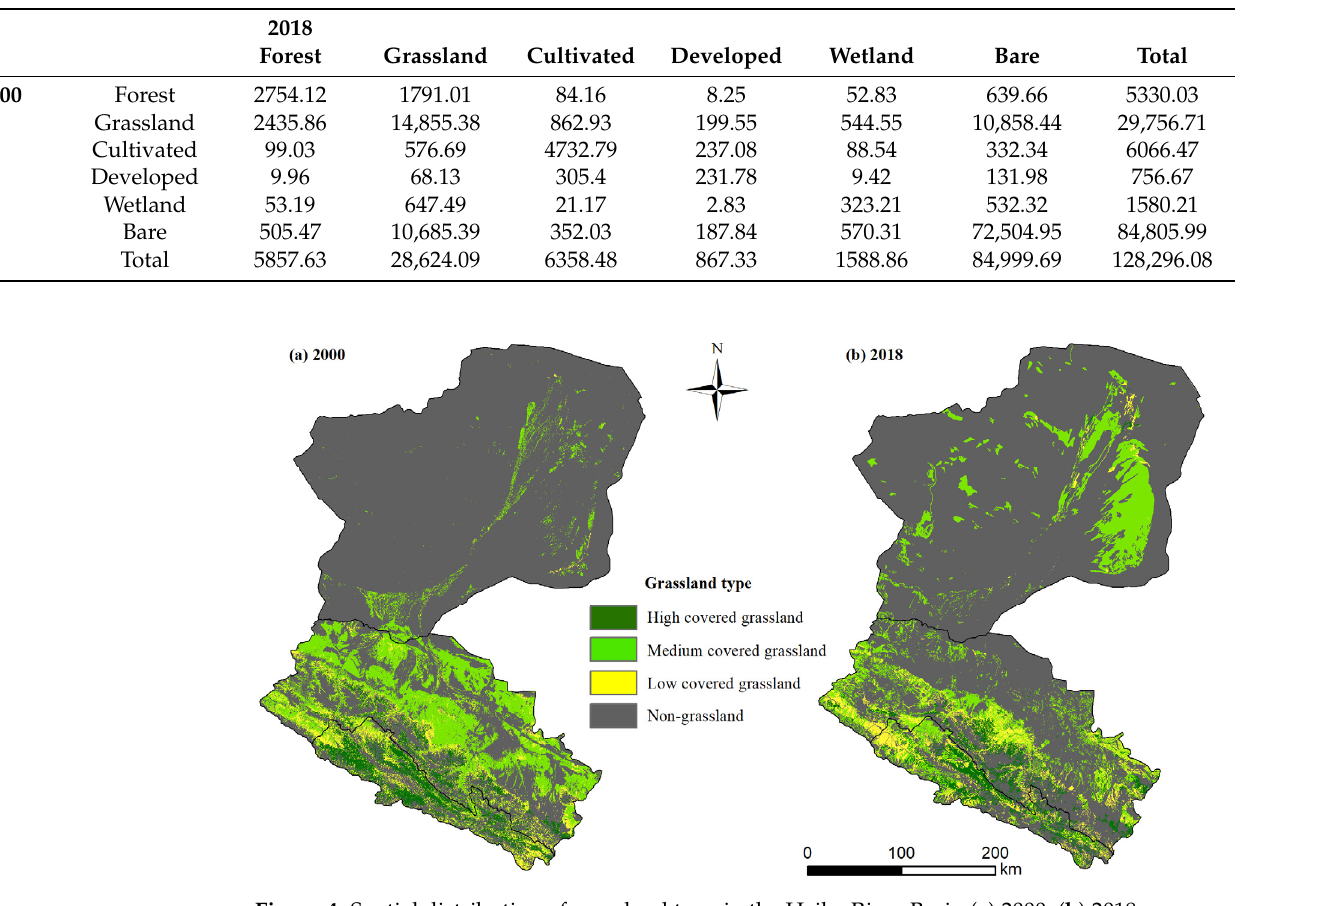
Figure 4. Spatial distribution of grassland type in the Heihe River Basin ( a ) 2000; ( b ) 2018. In 2000, the area of high-covered grassland, medium-covered grassland, and low- covered grassland was 5187.21 km 2 , 5944.10 km 2 , 18625.68 km 2 , respectively, accounting for 4.04%, 4.63%, and 14.52%, respectively. By 2018, the area of grassland coverage was 4501.80 km 2 , 6343.97 km 2 , and 17724.77 km 2 , which accounted for 3.51%, 4.95%, and 13.82%, respectively (Table 2). Obviously, the area of high-covered grassland and low- covered grassland was decreasing, while that of the medium-coverage grassland and non-grassland was increasing. Table 2. The type of grassland coverage in the Heihe River Basin from 2000 to 2018. Grassland